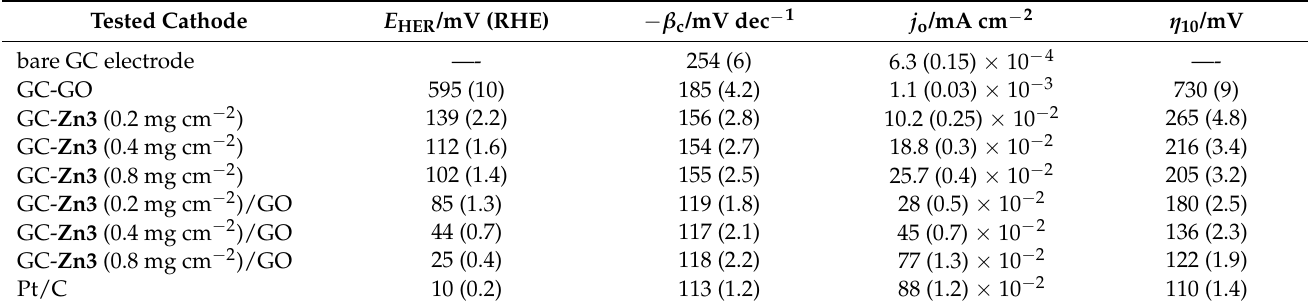
Table 4. Mean value (standard deviation) of the HER electrochemical kinetic parameters estimated for the investigated